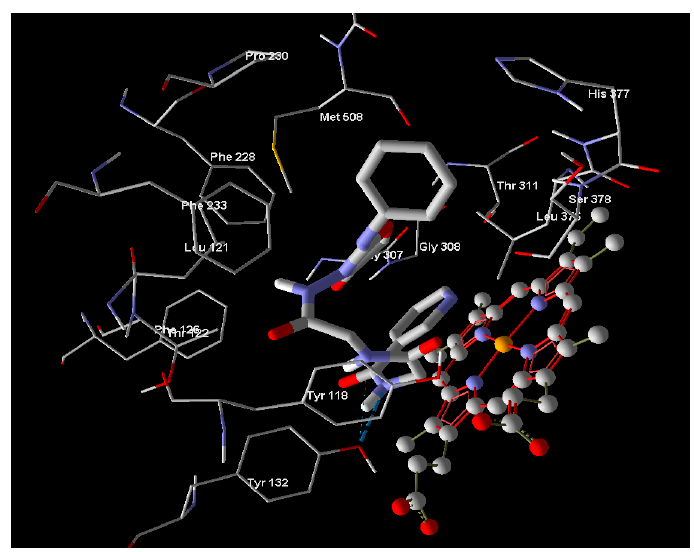
Figure 4. Binding mode of Compound 10 into the binding site cytochrome P450 14- α -sterol demethylase (Red: Oxygen, Blue: Nitrogen, Gray: Carbon, Dash line: Hydroegen bonds).